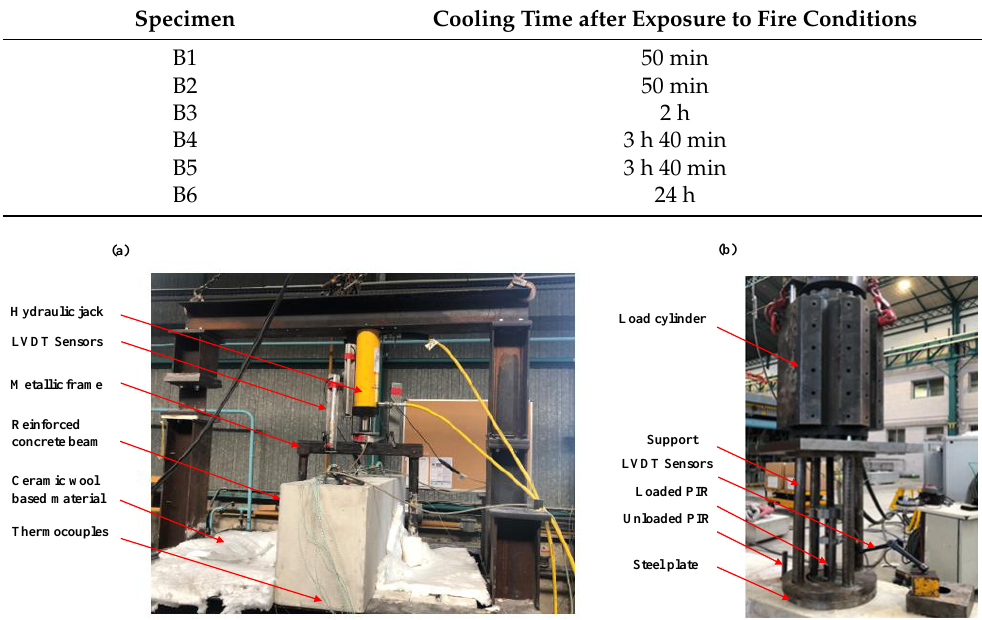
Figure 1. View of the gas furnace and the loading system during the heating phase. Table 2. Cooling duration after fire exposure.